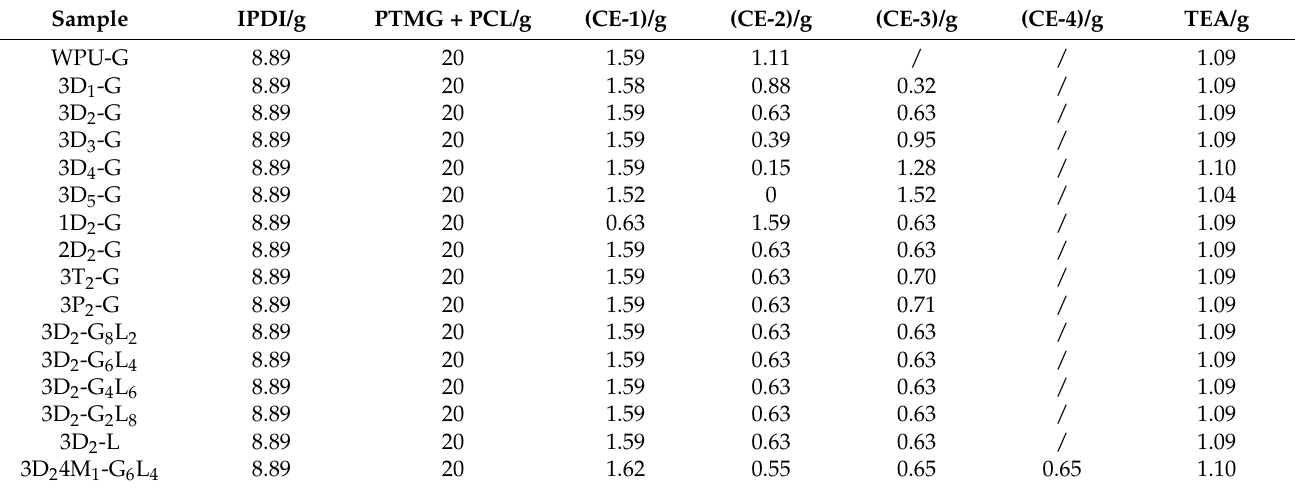
Table 1. Synthetic formula of WPU